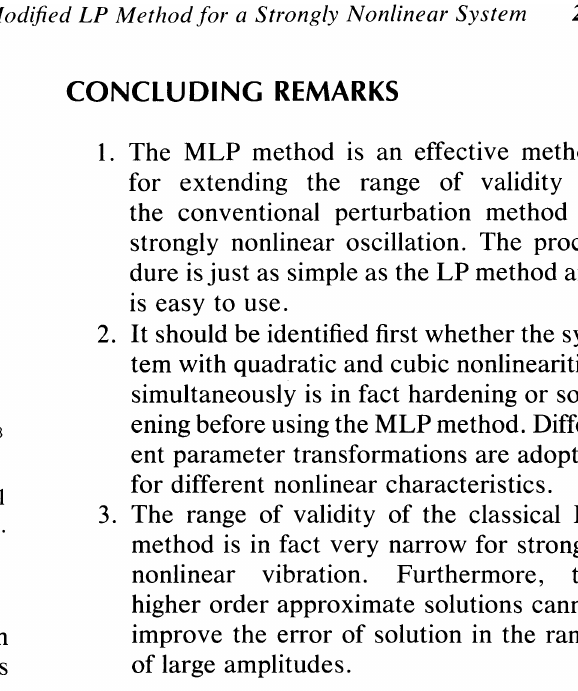
FIGURE 7 Comparison between transformations Tl and T2 for e = 1, Wo = 1, k2 = 0.8, k3 = 1.2, andp = O.